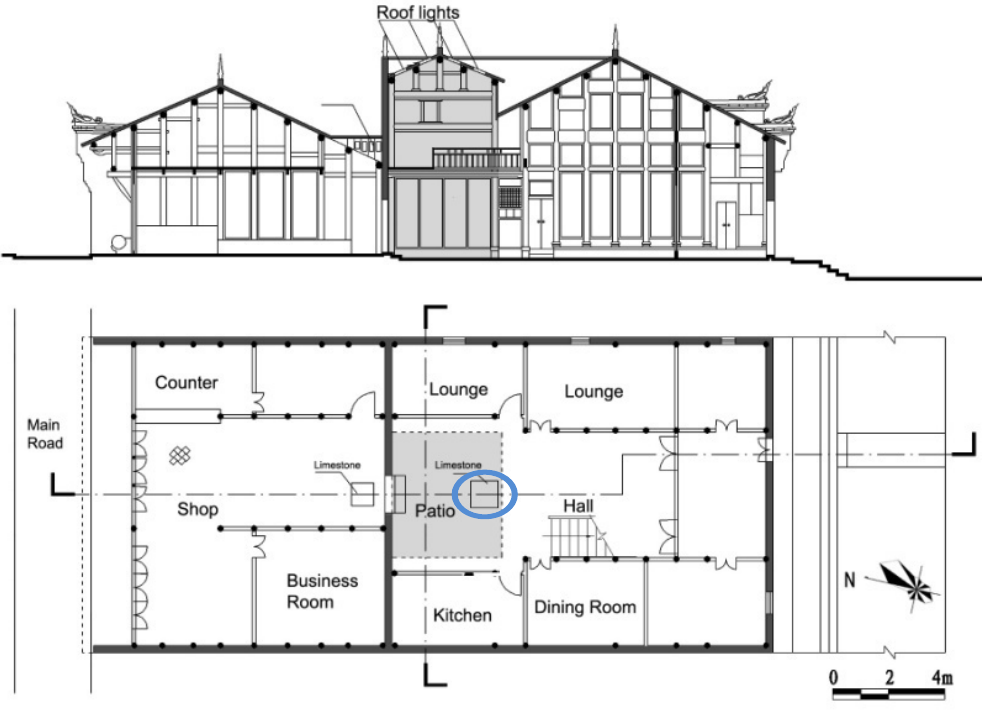
Figure 30. Zhai, S.B. House Plan and Section.